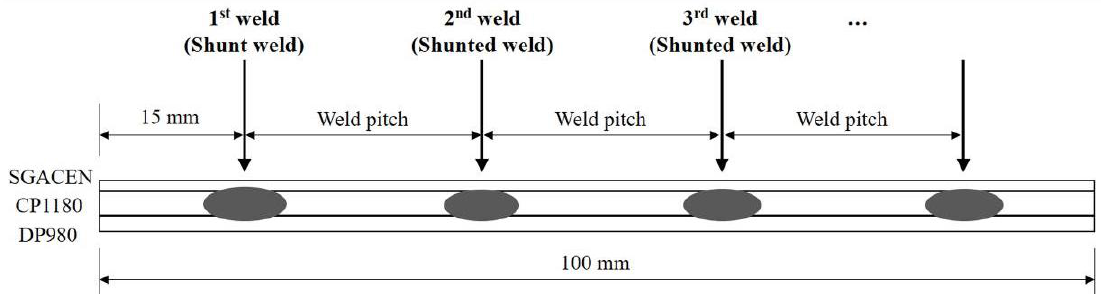
Figure 5. Resistance spot welding sequence applied to the test specimens. Steel sheets: low-carbon (SGACEN), complex-phase (CP1180), and dual-phase (DP980).